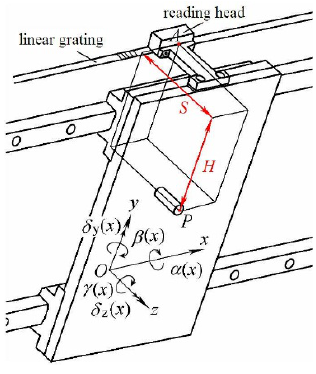
Figure 4. Slider motion in PCMM.